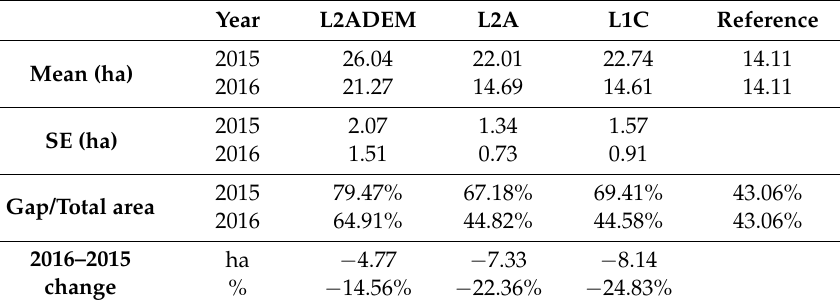
Table 9. Area evaluation results on